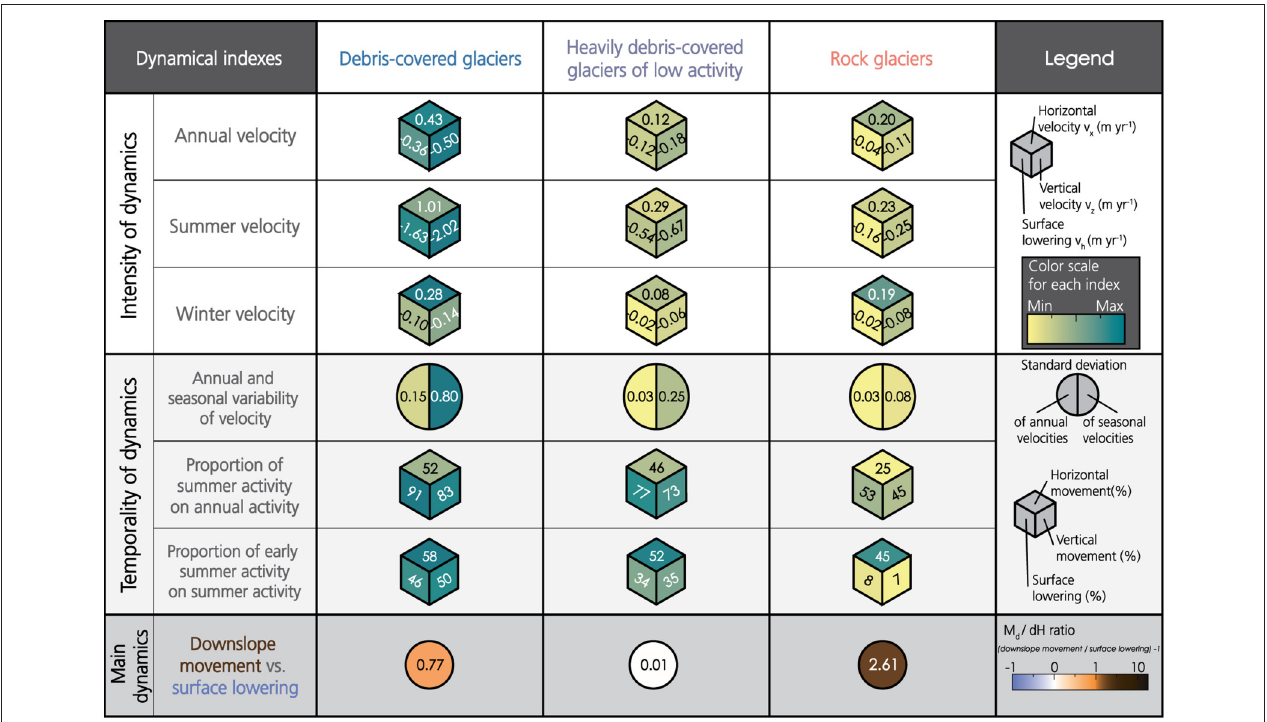
FIGURE 7 | Mean values of dynamical indexes calculated by zones where ice and debris are associated in the three study sites with dGPS data. The dGPS network used for this calculation appears in Figure 6B